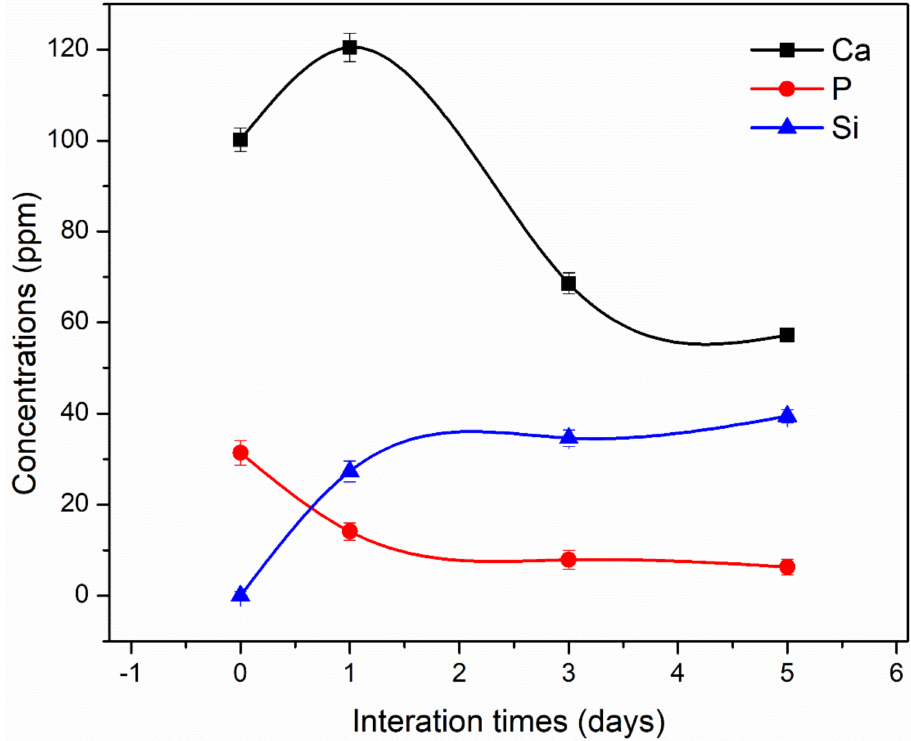
Figure 6. Ionic exchanges between the bioactive glass and the SBF